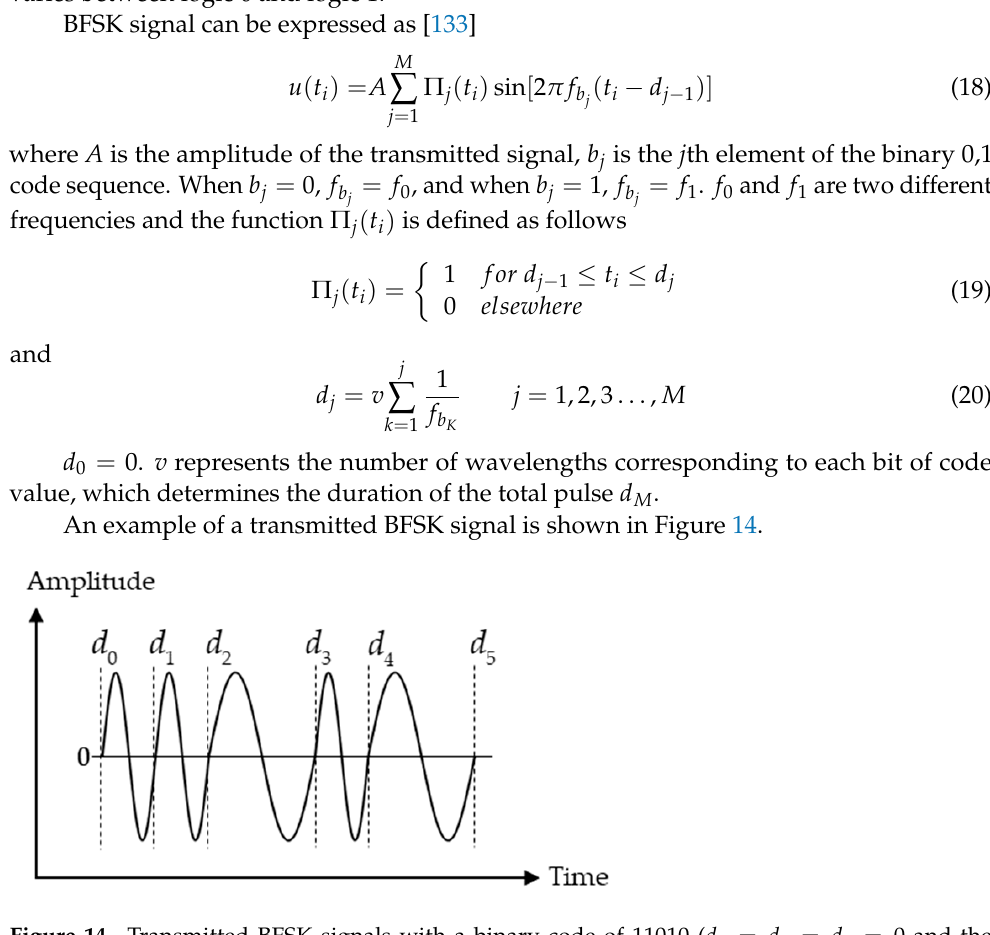
= and the corre- d = 0 f ). 1